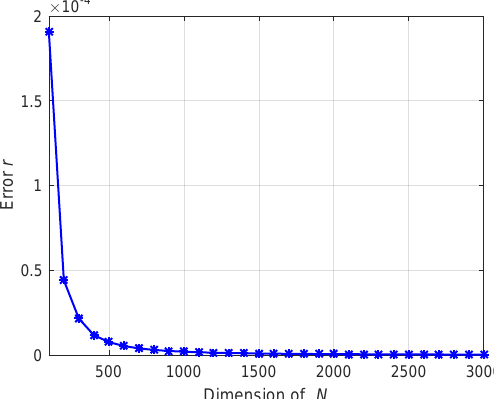
Figure 3. Approximated error with different N .